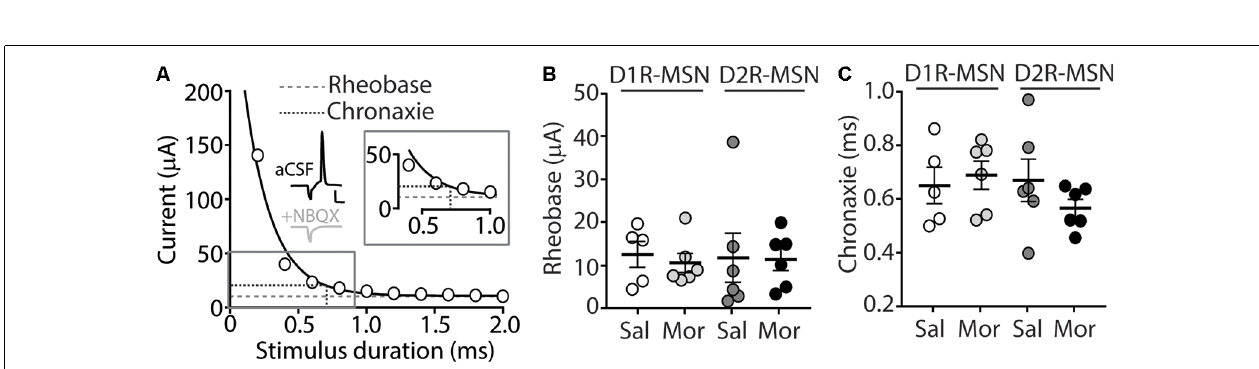
FIGURE 5 | Synaptically-driven action potential firing on D1R- or D2R-MSNs is unaffected by repeated morphine (10 mg/kg, i.p.) treatment. (A) Representative traces showing depolarizations or action potentials of a recorded MSN evoked by electrical current (in µ A) of 20 (light gray), 60 (blue), 100 (black), or 100 in the presence of NBQX (red), an AMPA receptor antagonist. Scale bars, 12.5 mV, 50 ms. (B,C) Summary graphs showing the average spike number at each current injected for D1R- or D2R-MSNs following saline or morphine treatment (cells/animals).